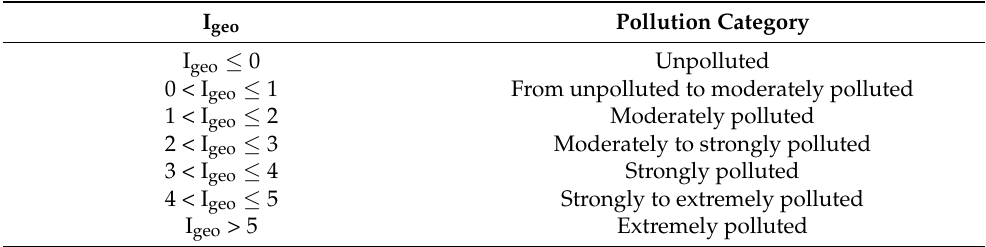
Table 2. The criteria of geo-accumulation